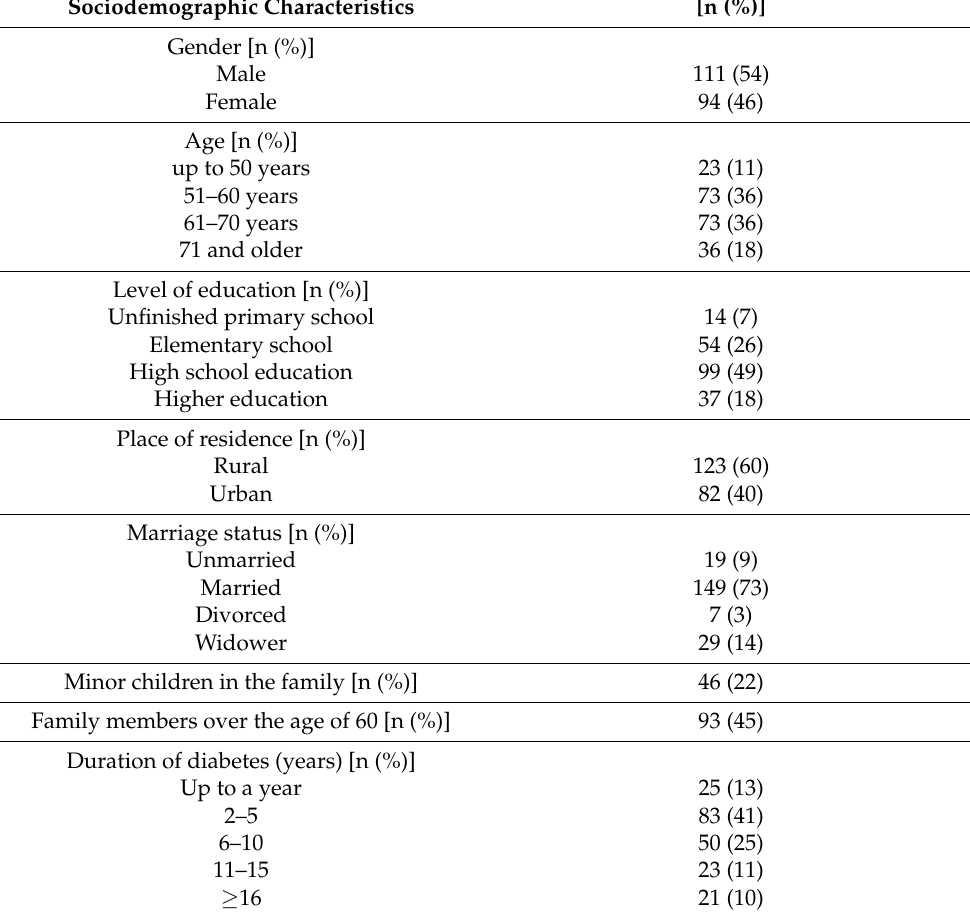
Table 1. Baseline characteristics of the